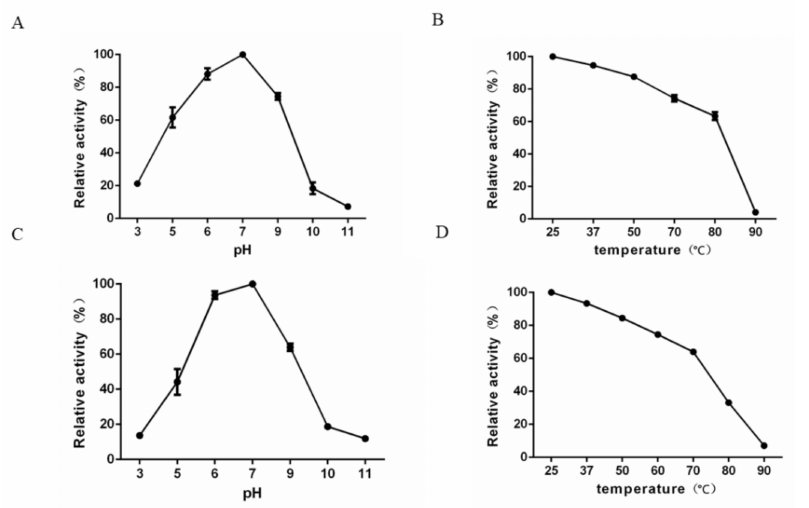
Figure 5. ( A ) Effect of pH on the enzymatic activity of K64-ORF41 at 25 ◦ C. ( B ) Effect of different temperatures on the enzymatic activity of K64-ORF41 at pH 7.0. ( C ) Stability of enzyme activity under different pH values. K64-ORF41 was pre-incubated alone in different pH values for 30 min, and the residual enzyme activity was measured at 25 ◦ C. ( D ) Stability of enzyme activity under different temperatures. K64-ORF41 was pre-incubated without substrate at various temperatures for 30 min, and the residual enzyme activity was measured at pH 7.0. The results are expressed as the relative activity by comparing with the values under optimal conditions. Data are expressed as means ± SD ( n =